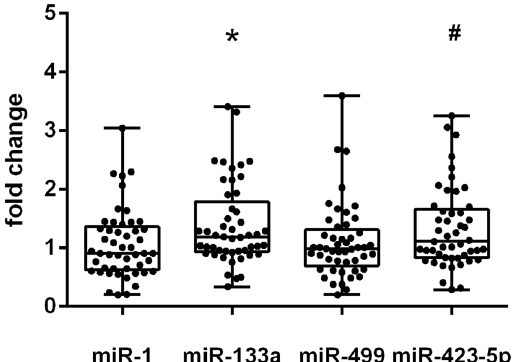
Figure 4. Expression of miR-133a and miR-423-5p in right atrial myocardial tissue after CABG. MiR-1, miR- 133a, miR-499, and miR-423-5p changes in right atrial myocardium of CABG patients (n = 49) after CPB compared to samples before CPB. Expression of miRNA was normalized to miR-16 and is presented as fold change versus baseline before CPB. Data are shown as box-whisker plots with median and all data points. Statistics: Wilcoxon matched pairs signed rank test, * P < 0.01, # P < 0.05 vs. before